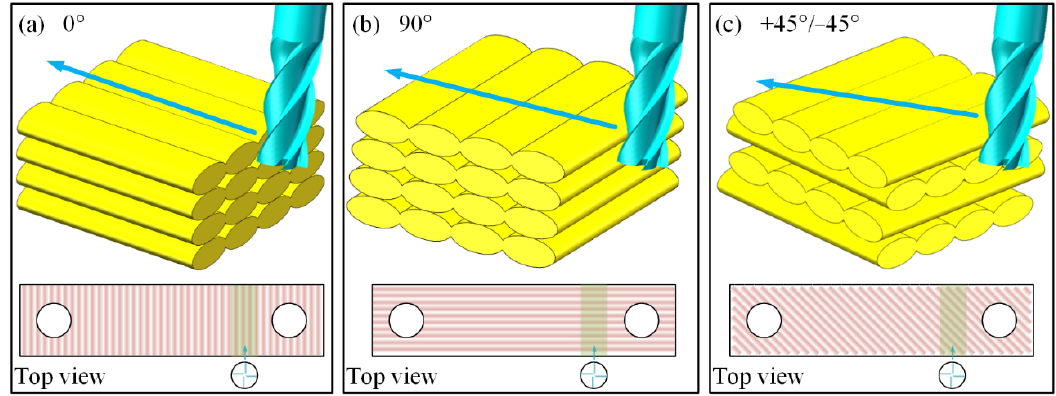
Figure 2. Schematic of milling direction for different RAs: ( a ) 0 ◦ ; ( b ) 90 ◦ ; ( c ) +45 ◦ / − 45 ◦ .